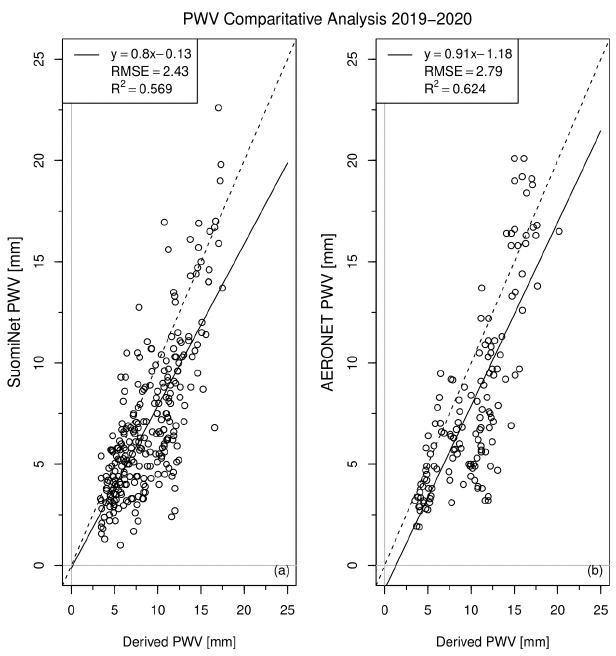
Figure 6. Comparison of SuomiNet PWV (a) and AERONET PWV (b) with PWV derived from our zenith sky temperature mea- surements using Eq. (2) over the period from January 2019 through January 2021. In both cases, the dashed line indicates a 1 : 1 rela- tionship, while the solid line shows the linear least-squares fit, with parameters indicated in each legend